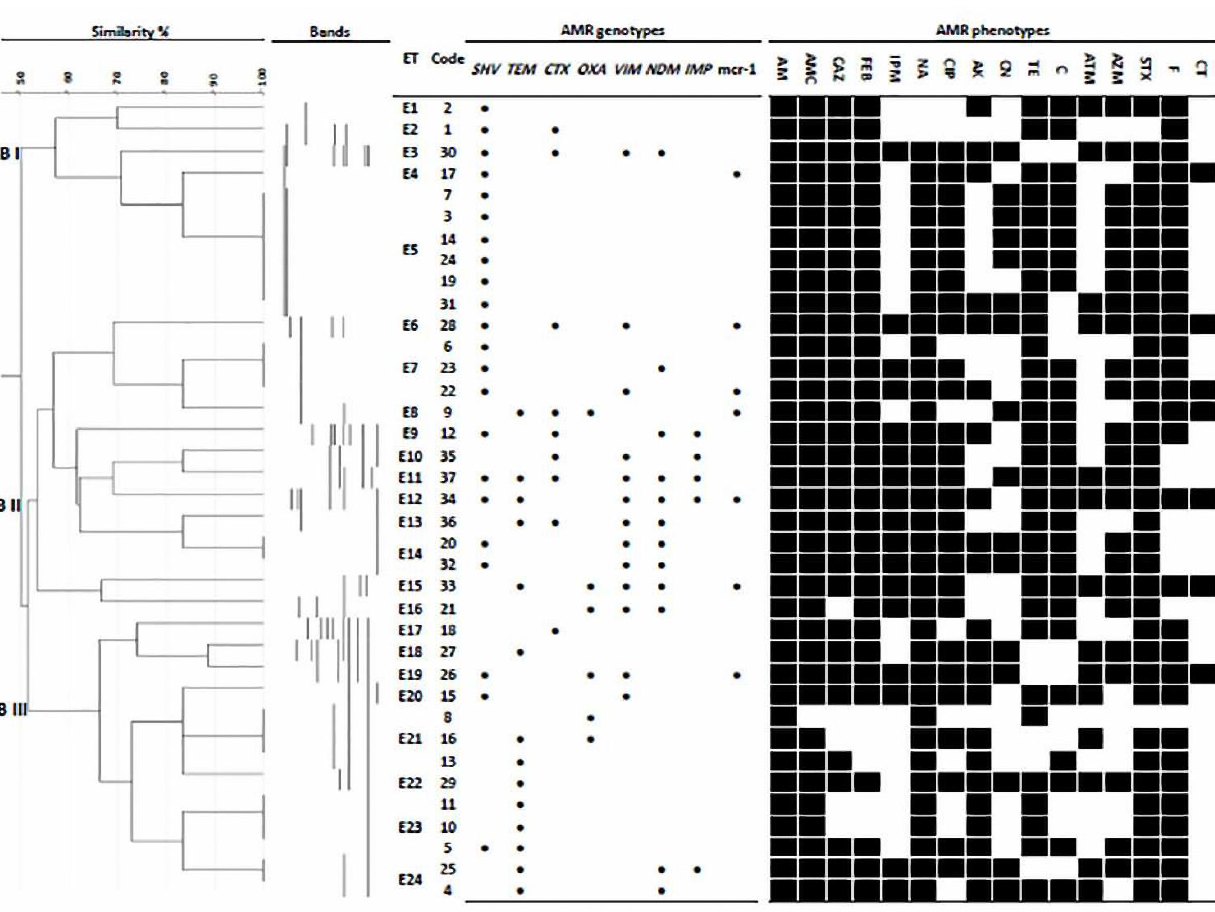
Figure 2. ERIC typing dendrogram of K. pneumoniae isolates from humans and chickens in the study area and their associated genetic and phenotypic antimicrobial resistance patterns. EB: ERIC branch; ET: ERIC type; black dot: positive for antibiotic resistance gene; black square: positive for antibiotic resistance phenotype; AMR: antimicrobial resistance; AMP: ampicillin; AMC: amoxicillin-clavulanic acid; CAZ: ceftazidime; FEB: cefepime; IPM: imipenem; NA: nalidixic acid; CIP: ciprofloxacin; AK: amikacin; CN: gentamicin; TE: tetracycline; C: chloramphenicol; ATM: aztreonam; AZM: azithromycin; SXT: trimethoprim-sulfamethoxazole; F: nitrofurantoin; CT: colistin.